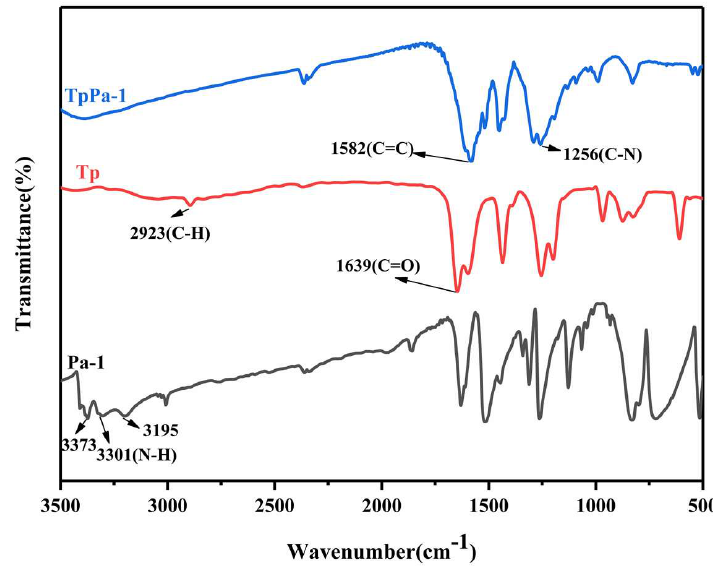
Figure 3. FT-IR spectra of Tp, Pa–1, and COF TpPa–1.